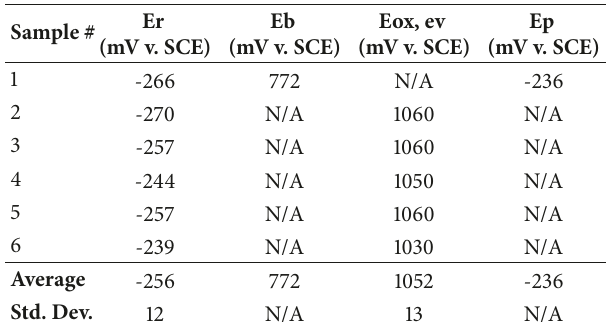
Table 2: Corrosion behavior of combustion synthesis porous